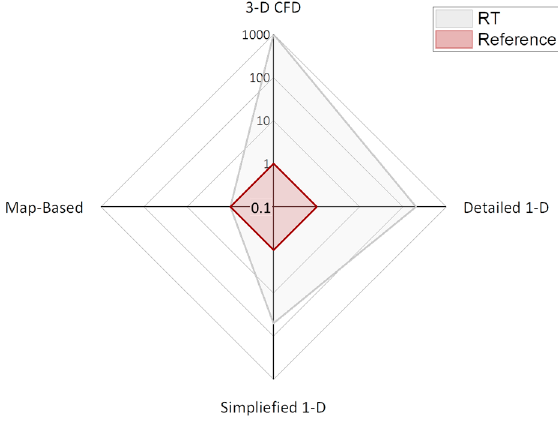
Figure 11. RT comparison.